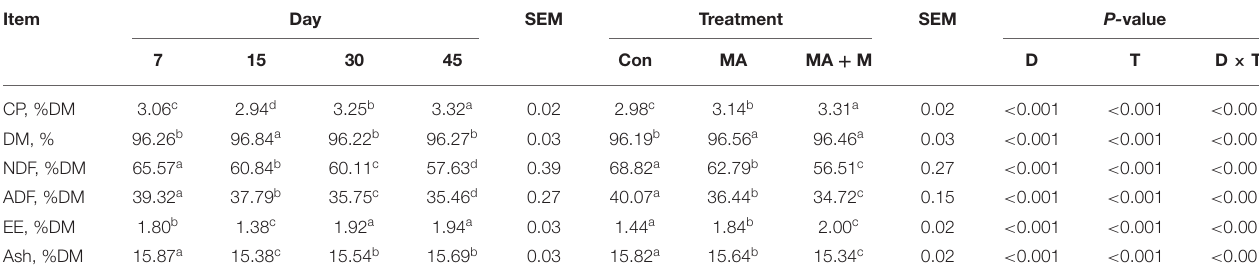
TABLE 1 | Effect of MA pretreatment and anaerobic storage days on the chemical composition of rice straw (%,